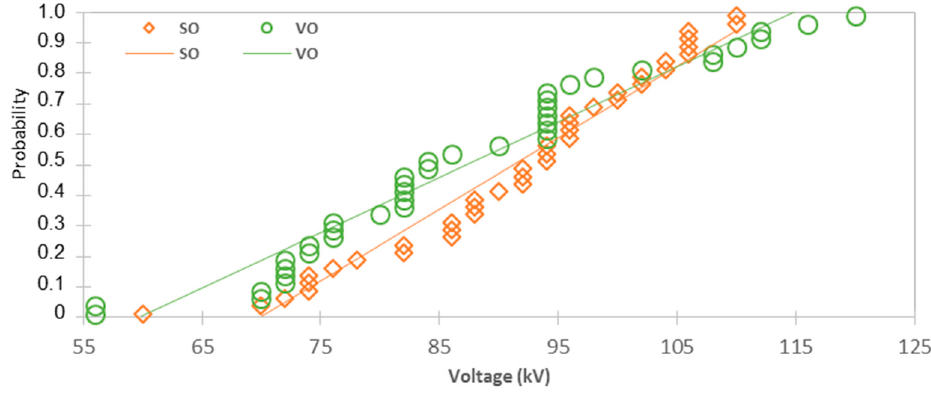
Figure 6. Probability of normal distribution of AC breakdown voltage of oils alone.